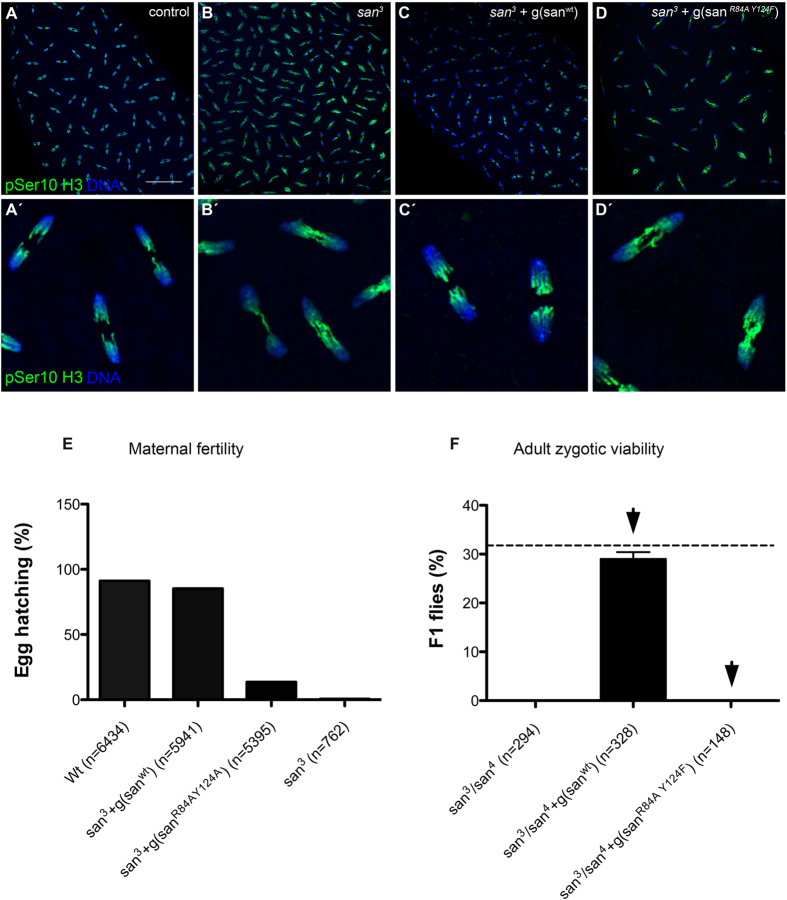
The catalytic activity of Naa50/San is essential for viability and normal mitosis.A wild type (g(sanwt)), but not a catalytically dead-version (g(sanR84A Y124F)) of a genomic construct that encodes Naa50/San, was able to rescue the chromosome segregation defects of syncytial blastoderm embryos mutant for san3 (maternal mutants)40
(A–D’), the fertility of females whose germ line was mutant for san
(E), and the adult viability of zygotic mutants of san
(F). Loss of Naa50/San (SanR84A Y124F) mutant protein Nt-Ac catalytic activity is shown in Fig. 5B. (A–D’) All panels show syncytial blastoderm embryos. Control wild type (A,A’), san mutant (san3) (B,B’), san mutant with a wild type genomic construct (san3 + g(sanwt)) (C,C’), and san mutant with a catalytically dead genomic construct (san3 + g(sanR84A Y124F)) (D,D’). Both wild type (g(sanwt)) and catalytically dead genomic constructs (g(sanR84A Y124F)) contained the gene endogenous minimal promoter and were integrated in the same attP2 site. All embryos were stained for DNA (blue) and pSer10 Histone H3 (green). (E) Embryonic hatching of fertilized eggs laid by females whose germ line was wild type (control), mutant for san with a wild type genomic construct (san3 + g(sanwt)), mutant for san with a catalytically dead genomic construct (san3 + g(sanR84A Y124F)), and mutant for san (san3) was, respectively, 91.1% ± 5.6 (n = 6434), 85.1% ± 1.6 (n = 5941), 13.5% ± 2.4 (n = 5395), and 0.5% ± 0.7 (n = 762). (F) A genomic construct carrying a wild type copy of san efficiently rescued the zygotic lethality of two loss-of-function alleles of san40 (adult viability: san mutant [san3/san4] = 0% (n = 294, adult flies); san mutant + g(sanwt) [san3/san4; g(sanwt)/+] = 29% ± 1 (n = 328, adult flies; full complementation should correspond to 33% of total Drosophila flies (dashed line)). A genomic construct carrying a catalytically dead allele of san g(sanR84A Y124F) failed to rescue the zygotic lethality of two loss-of-function alleles of san (adult viability: san mutant [san3/san4] = 0% (n = 294, adult flies); san mutant + g(sanR84A Y124F) [san3/san4; g(sanR84A Y124F)/+] = 0% (n = 148, adult flies; full complementation should correspond to 33% of total Drosophila flies). For more experimental detail see Supplementary Table 3.